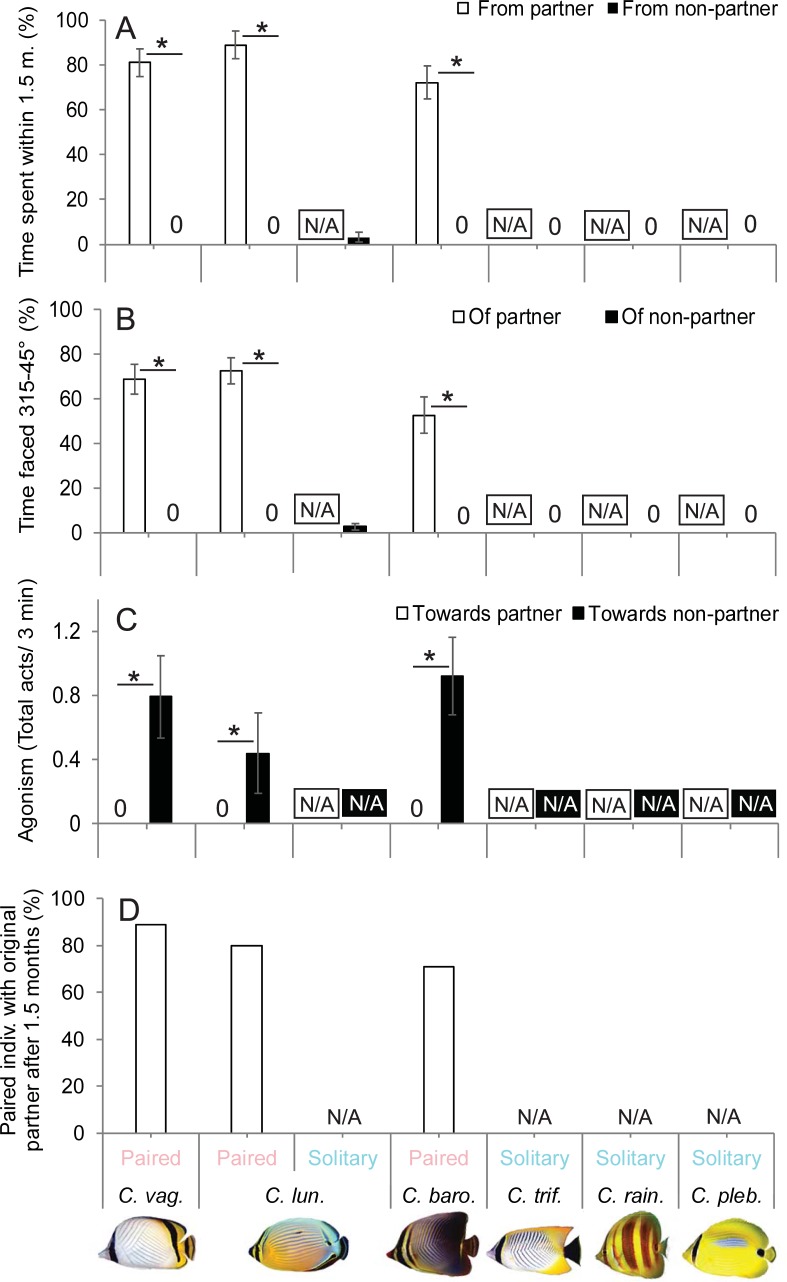
Differences in social behaviors between predominantly paired and solitary grouped Chaetodon spp. and C. lunulatus individuals.(A) Time spent proximate swimming with another conspecific (mean % ± standard error). (B) Time spent parallel swimming with another conspecific (mean % ± standard error). (C) Agonism towards partner vs. non-partner conspecifics among pairs (mean % ± standard error). (D) Percentage of pairs displaying partner fidelity after six weeks. Asterisks indicate significant differences between groups. N/A = not applicable.